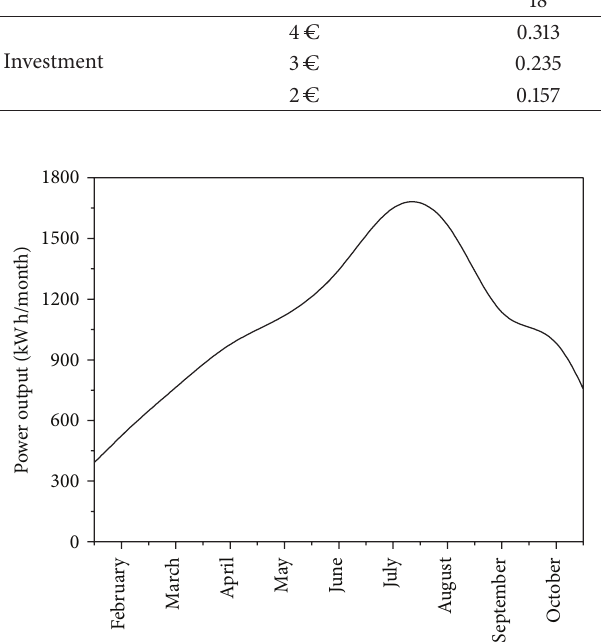
Figure 6: The power output of the solar panels in Arendonk (Feb 2011–Oct 2012).